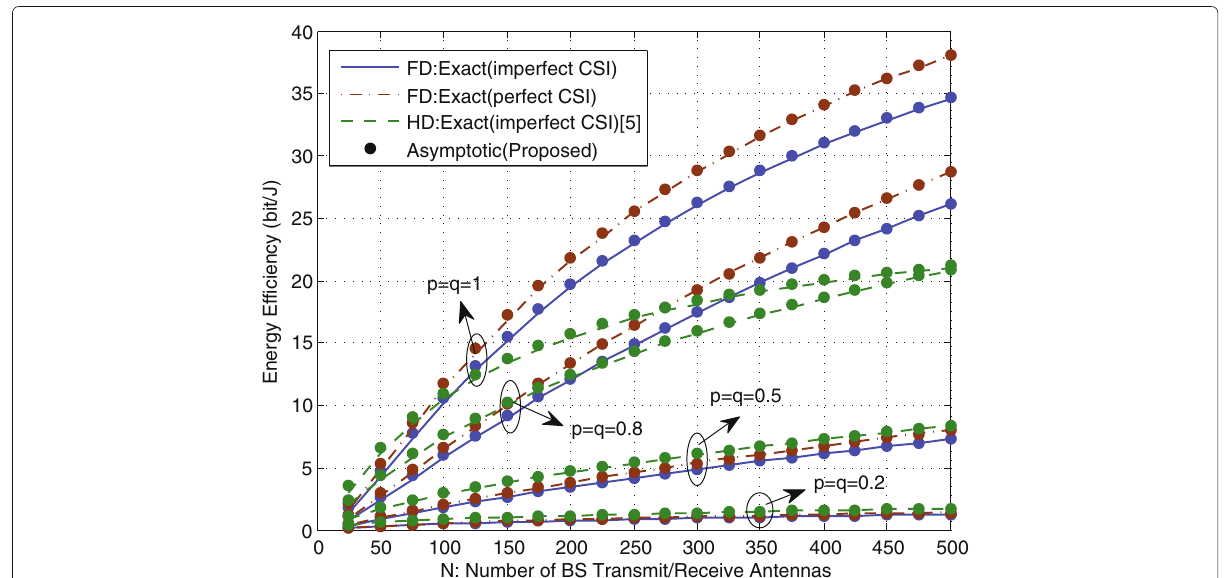
Fig. 4 Comparison of FD and HD EE for different power scaling schemes versus N under perfect CSI and imperfect CSI with E U = 10 dB, E D = KE U , P P = 0 dB, and β LI = 10 dB